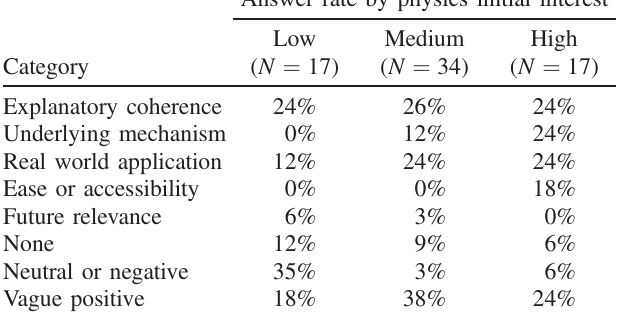
TABLE V. Rates of categories of open-ended responses by initial physics interest categories, from matched data set. (Five students who are part of the matched data set did not provide open-ended responses and thus are not represented) Full data set of open-ended responses includes 123 total responses and shows equivalent